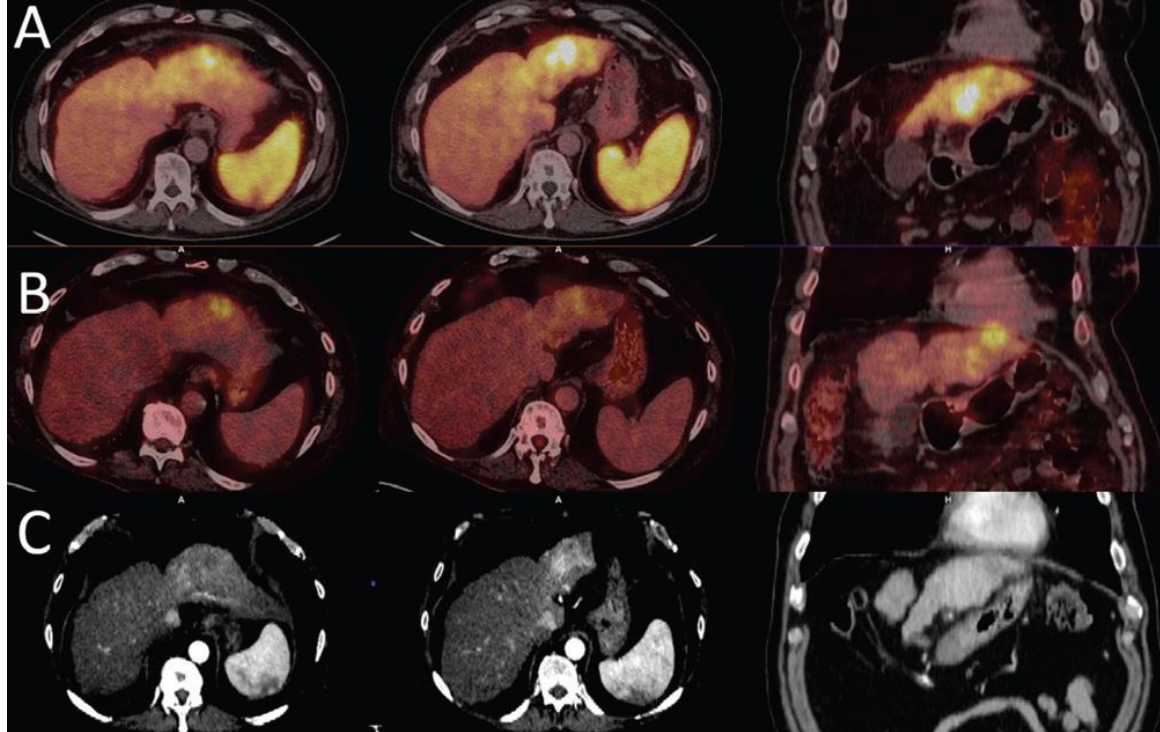
Figure 1. Liver cirrhosis with HCC in the left lobe of the liver. 68 Ga PSMA ( A ) shows higher uptake in the hyperenhancement areas of the arterial phase CT images ( C ) than the focal 18 F -FDG uptake area ( B ), which is noted to appear hypodense on CT (images reproduced with permission from [46] ) .